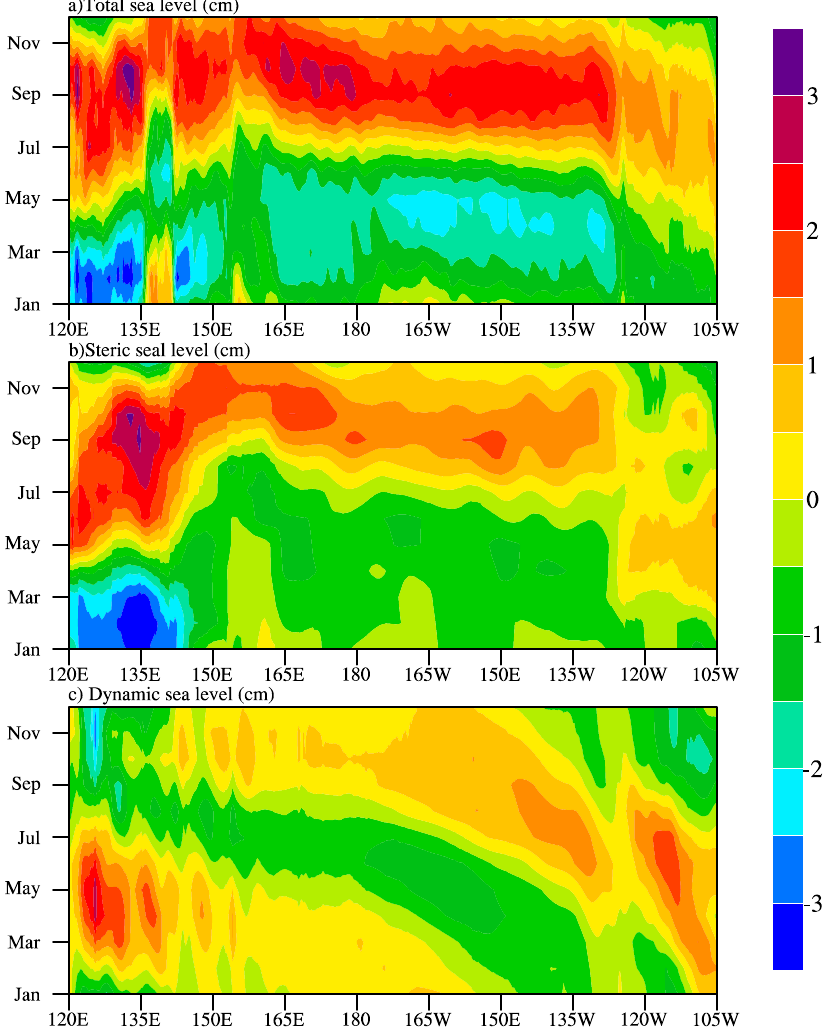
Figure 3. Time–longitude plot of the seasonal sea level anomalies (cm) averaged along the 20° S–20° N latitudinal band from ( a ) altimetric observations, ( b ) the steric effect, and ( c ) the 1.5-layer model.